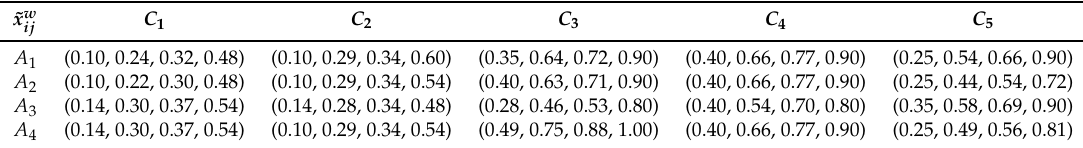
Table 4. The normalized aggregated decision matrix ˜ D .